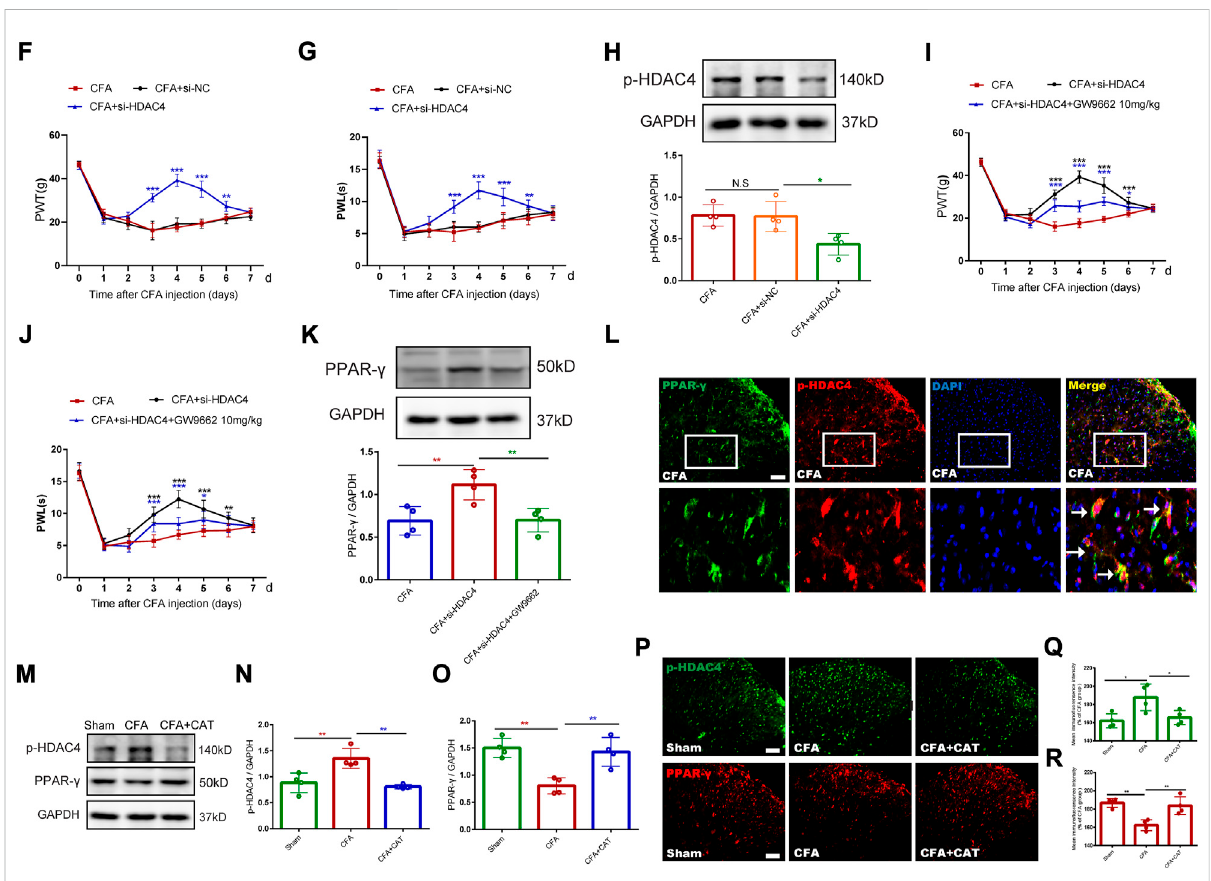
FIGURE 4 EffectofcatalpolonHDAC4/PPAR- γ -signalingpathwayinspinalcordofCFArats. (F,G). EffectofintrathecalinjectionofHDAC4siRNA(5 μ g)on PWT and PWL. (** p < 0.01, and *** p < 0.001 vs. CFA group; n = 6, two-way repeated measures ANOVA). (H). The relative protein expression of p-HDAC4. ( p p < 0.05 vs. the CFA group; n = 4, one-way ANOVA, N.S: not statistically signi fi cant). (I,J). Effect of GW9662 administration on PWT and PWL. (* p < 0.05, ** p < 0.01, and *** p < 0.001 vs. the CFA + si-HDAC4 group; n = 6, two-way repeated measures ANOVA). (K). The relative proteinexpressionofPPAR- γ .(** p < 0.01,vs.theCFA+si-HDAC4group;n=4,one-wayANOVA). (L). Theco-expressionofp-HDAC4andPPAR- γ